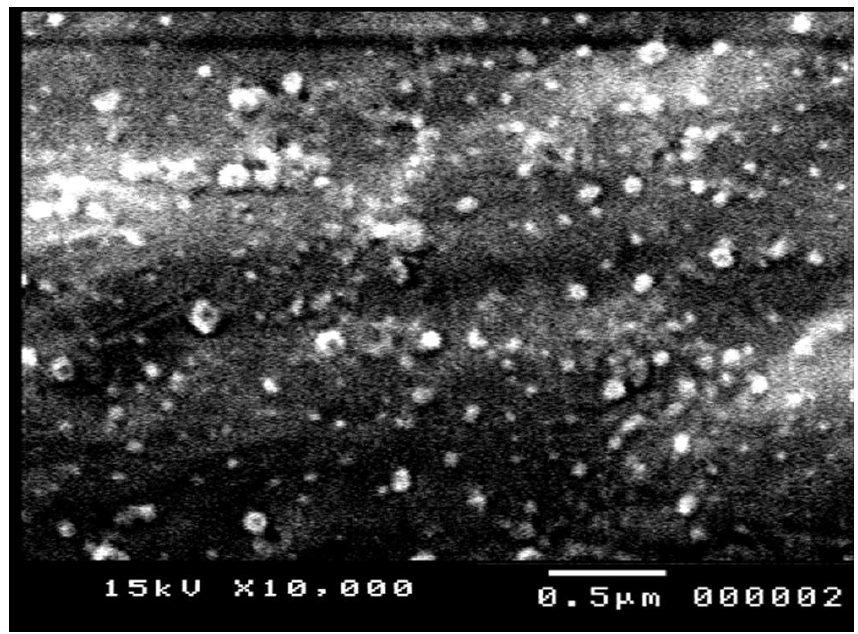
Figure 5. Scanning electron microscope photomicrograph of RT NCs prepared using HP- β -CD as a stabilizer (F2).